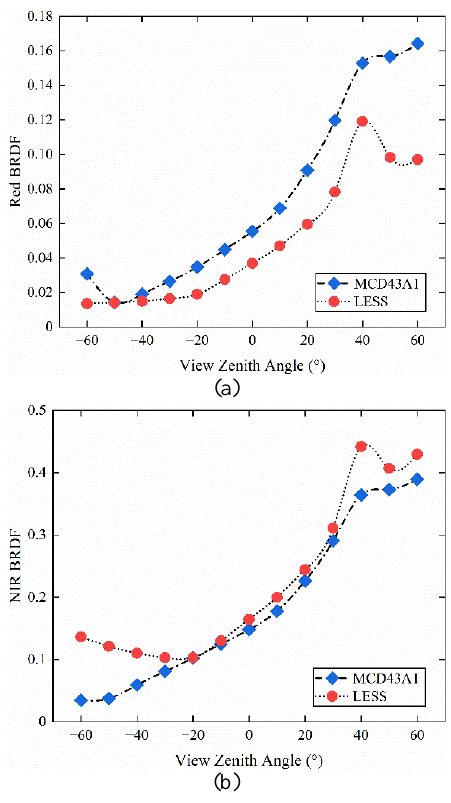
Figure 4. Comparison of the simulated BRDF by the LESS Figure 5. BRDF simulated the LESS model along with the model and MCD43A1 BRDF along with the VZA in the (a) red increased LAI against the VZA in the (a) red band and (b) NIR band and (b) NIR band. band. LAI was gradually increased from 2 m 2 /m 2 to 6 m 2 /m 2 with a data change interval of 2 m 2 /m 2